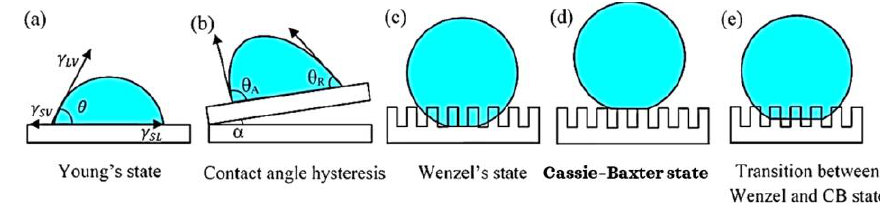
Figure 2. Various states of a water droplet on a solid surface [70]. Reprinted with permission from Ref. [70]. Copyright 2020 American Chemical Society.